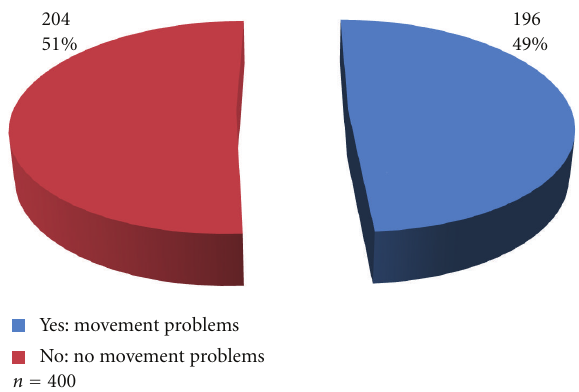
Figure 1: Prevalence of movement/functional problems in house- holds.